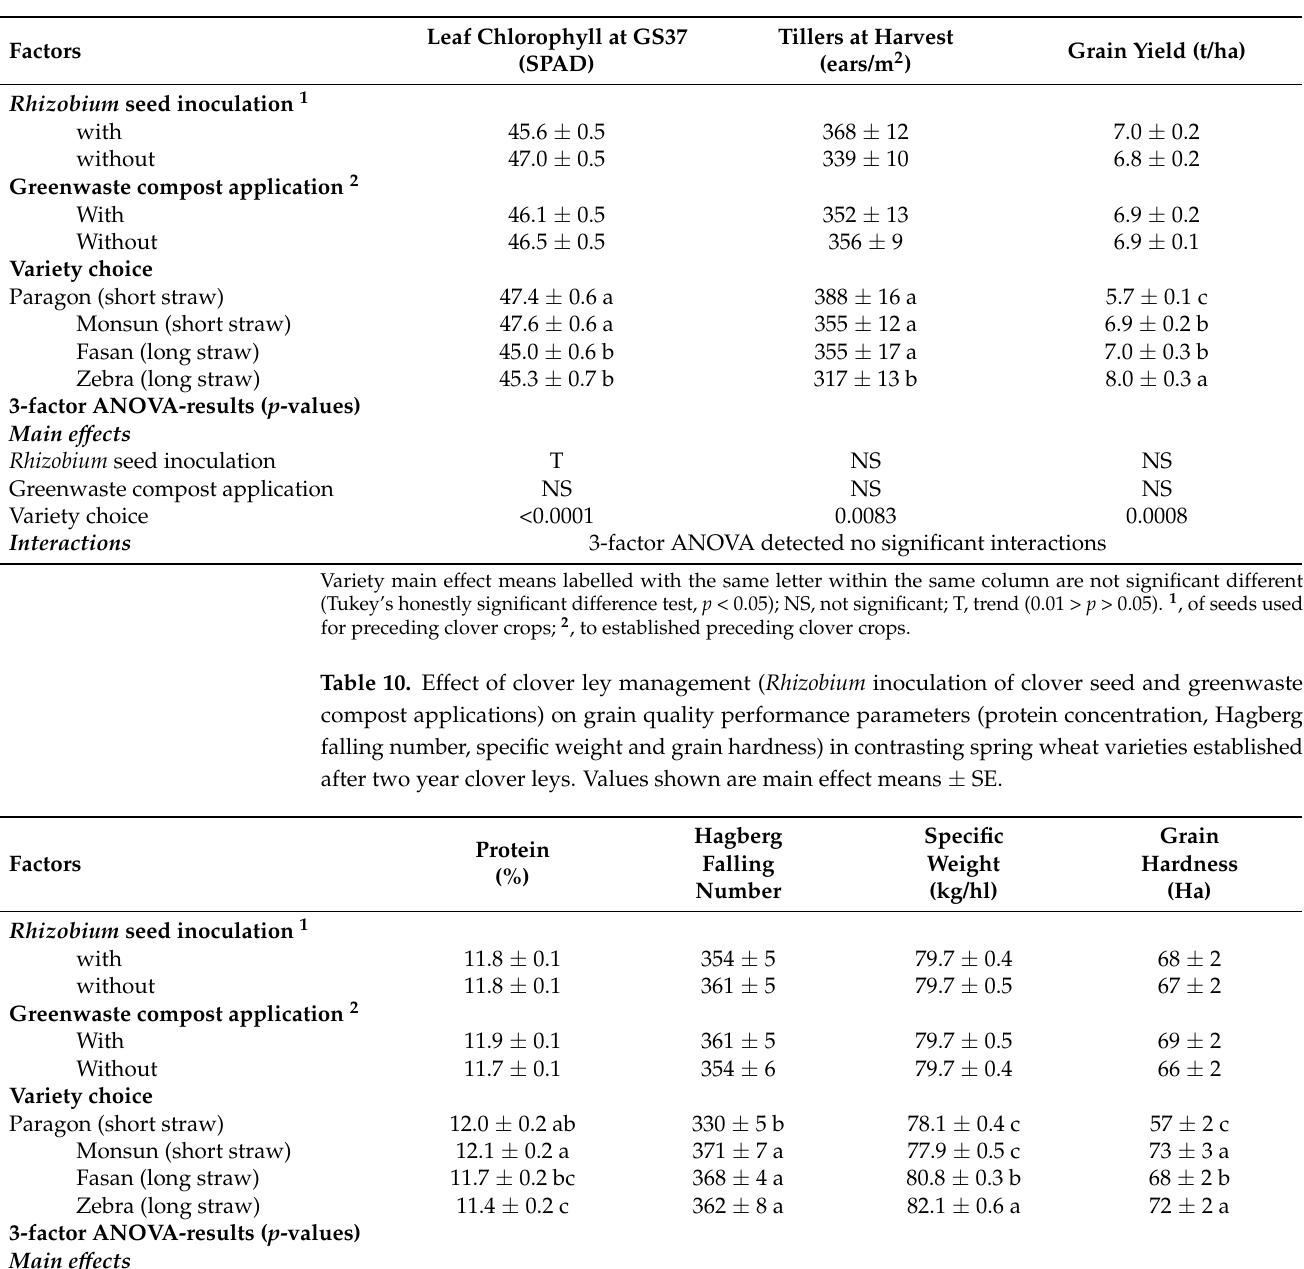
Table 9. Effect of clover ley management ( Rhizobium inoculation of clover seed and greenwaste compost applications) on performance parameters (estimated leaf chlorophyll levels at growth stage 37, tiller numbers at harvest, grain yield) in contrasting spring wheat varieties established after two year clover leys. Values shown are main effect means ± SE.